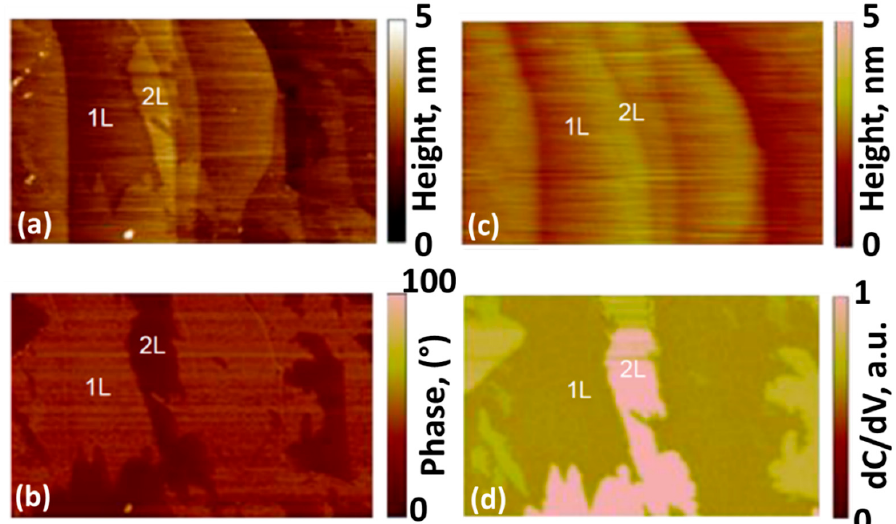
Figure 3. Tapping-mode AFM morphology ( a ) and phase ( b ) images of bilayer-patched epitaxial graphene on 4H-SiC. ( c ) Contact-mode AFM morphology of the same sample. ( d ) Derivative of the capacitance (dC/dV) between tip and sample.